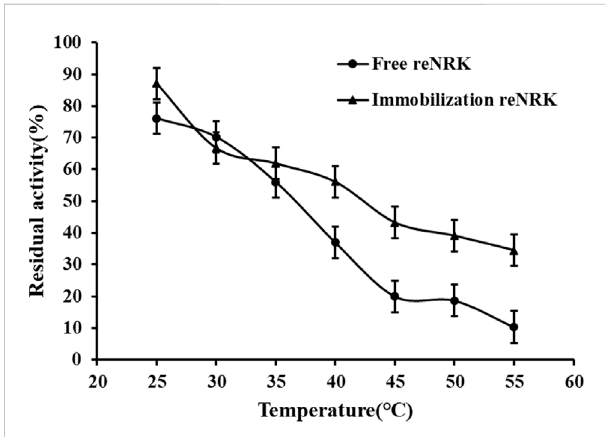
FIGURE 6 The temperature stability of the re Sc NRK1. The residual enzyme activity was measured at its optimal reaction temperature after being preincubated 1 h respectively.